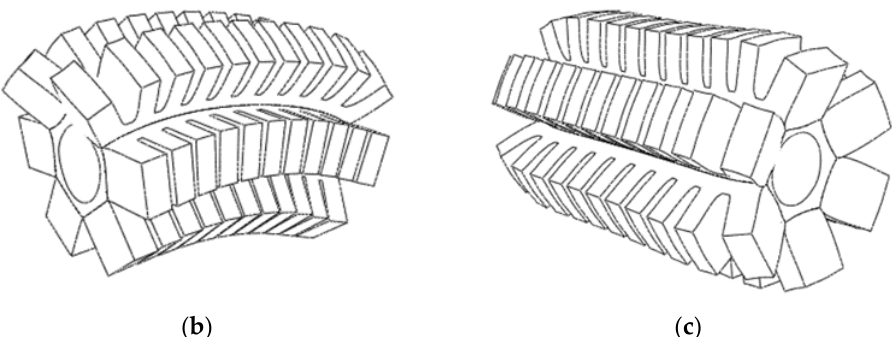
Figure 3. Deformation diagram of hexagonal prism soft-bodied bionic actuator. ( a ) Status of actuator not inflation. ( b ) State of bending deformation. ( c ) State of expansion deformation.